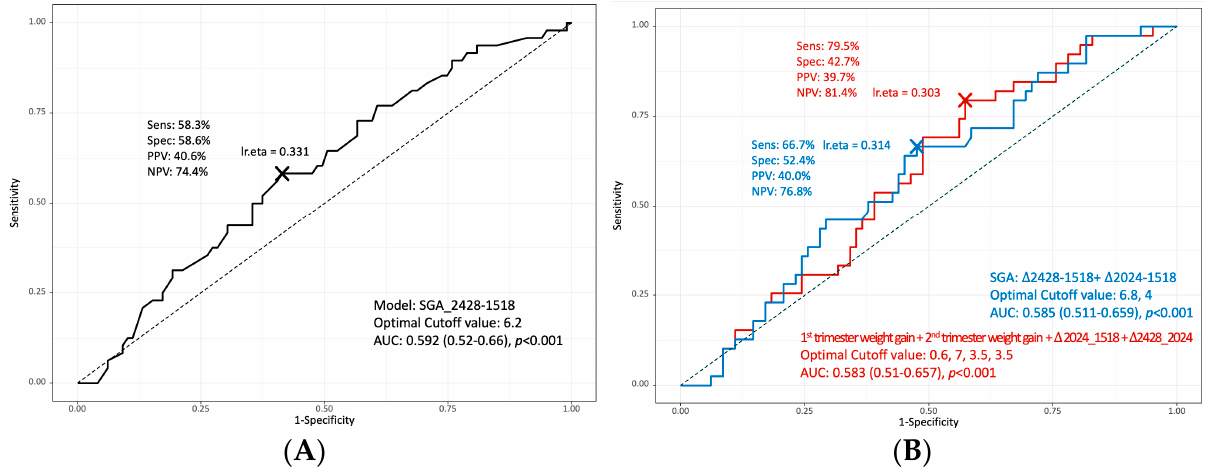
Figure 1. Area under the curve (AUC) of the predictive values for maternal weight and weight gain during pregnancy for the small for gestational age (SGA) group in twin pregnancy. ( A ) Among various weight gain values by pregnancy period, weight gains during 24–28 and 15–18 weeks, i.e., during the second trimester of pregnancy, were the most significant predictive factor, with an AUC = 0.592 and a cutoff value of 6.2 kg. ( B ) The weight gain value for each pregnancy trimester was simultaneously analyzed, and the AUC value that can predict the rate of SGA was confirmed. The blue line indicates weight gain between 24–28 and 15–18 weeks and between 20–24 and 15–18 weeks, with an AUC of 0.585 and cutoff values of 6.8 and 4 kg, respectively. The orange line indicates the SGA prediction using weight gain in the first trimester, weight gain in the second trimester, weight gain between 20–24 and 15–18 weeks, and weight gain between 24–28 and 20–24 weeks, with cutoff values of 0.6, 7, 3.5, and 3.5 kg, respectively (AUC =